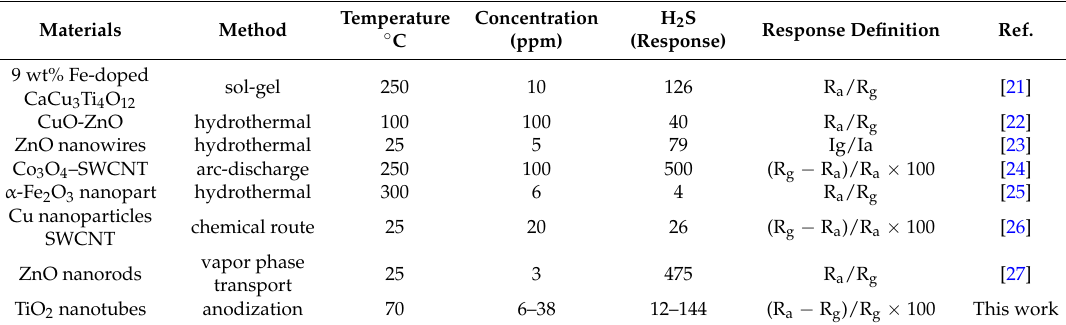
Table 1. Gas-sensing response of recently reported metal oxide sensors toward H 2